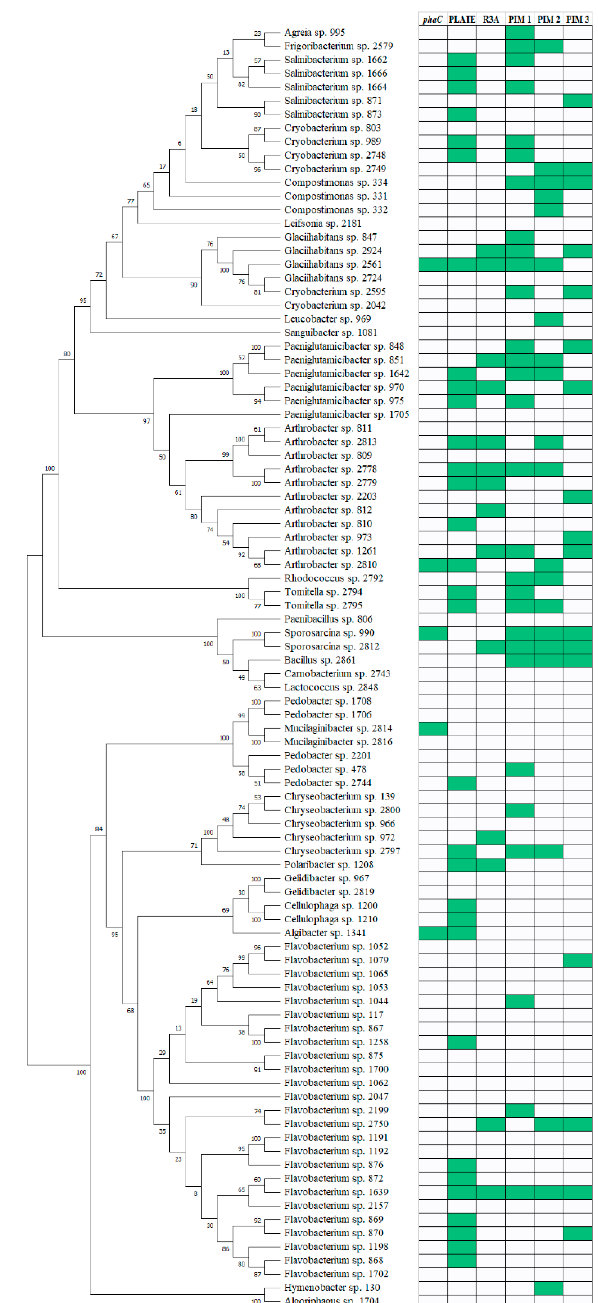
Figure 3. Phylogenetic tree based on partial 16S rRNA gene sequences belonging to the Actinobacteria, Firmicutes, and Bacteroidetes phylum lined up with the results from the PHA screening with various methods. The tree was built using the neighbor-joining method. Bootstrap values are indicated at the nodes. Green boxes indicate a positive score. phaC —presence of the 550 bp DNA fragment of the phaC gene; PLATE—presence of characteristic fluorescence on R3A agar plates with Nile Red after UV exposure; R3A—presence of red-fluorescing granules in Nile Red stained cells cultured on R3A broth; PIM1—presence of red-fluorescing granules in Nile Red stained cells incubated in PIM1 medium; PIM2—presence of red-fluorescing granules in Nile Red stained cells incubated in PIM2 medium; PIM3—presence of red-fluorescing granules in Nile Red stained cells incubated in PIM3 medium.